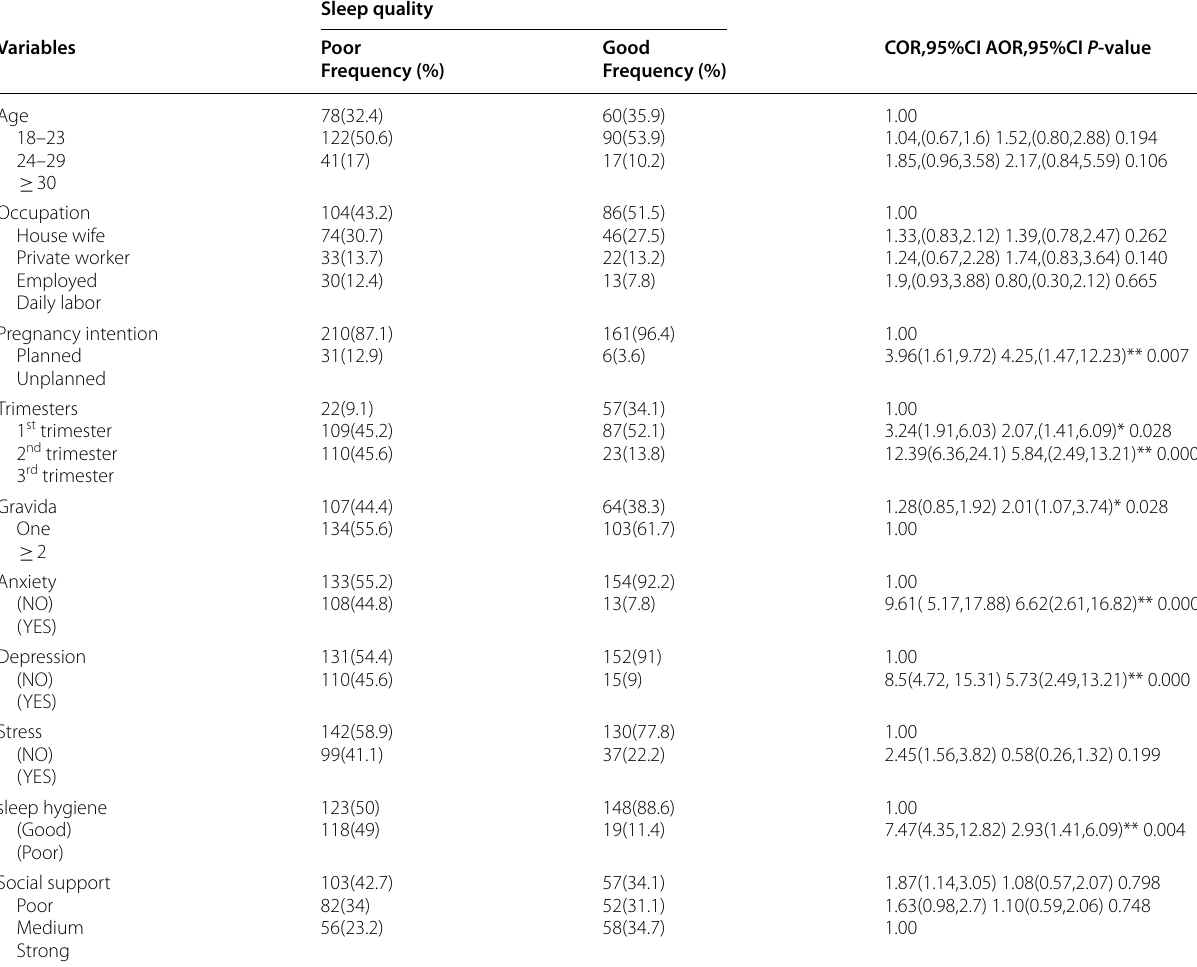
408), Nekemte, Ethiopia, 2019( n 408) = =